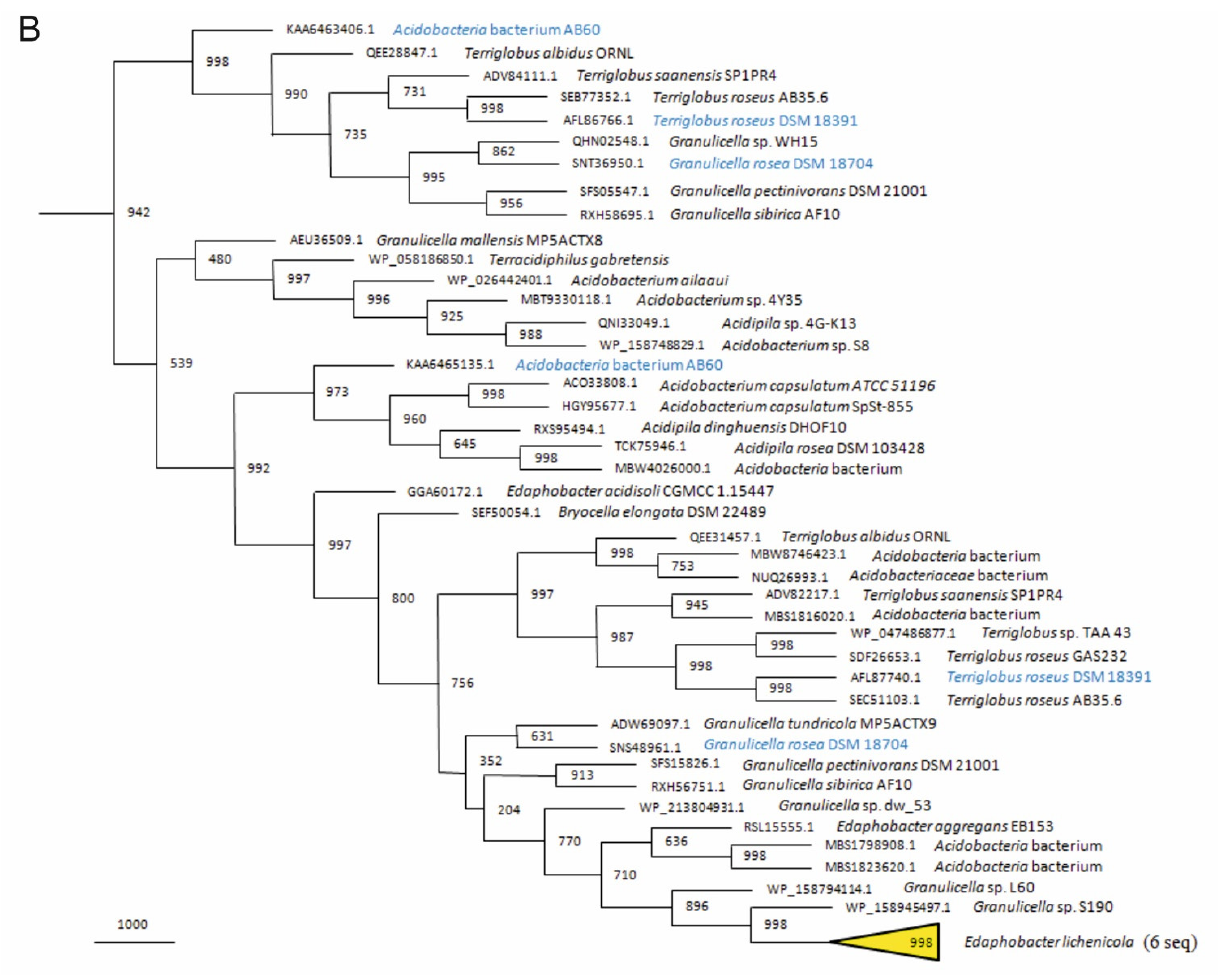
Figure 7. The maximum parsimony phylogenetic tree of the acidobacterial catalytic subunit BcsAB of cellulose synthase. Statistical significance of the tree was assessed by bootstrap analysis; the number of supporting pseudoreplicates (out of 1000) is indicated next to each branching site. ( A ) A simplified scheme of the phylogenetic tree with six undisclosed branch clusters (I–VI) of closely related proteins. The bootstrap support of each cluster is given within the corresponding triangle, and the number of proteins is indicated next to the triangle. Cluster I contains nine proteins encoded by metagenomes (GenPept: MBE7544888.1, MBI1352977.1, MBI4909624.1, MBL0156305.1, MBL8212404.1, MBN8729825.1, MBV8549744.1, PYV80644.1, and PYX09599.1). Cluster VI contains six proteins encoded by different strains of Edaphobacter lichenicola (MBB5315980.1, MBB5331838.1, MBB5338266.1, MBB5346008.1, NYF52494.1, and NYF89476.1). Structure of the four clusters (II–V) is shown in ( B ). Protein ACPOL_3662 (AXC12945.1) from Acidisarcina polymorpha SBC82 T is shown in red. Proteobacterial proteins with experimentally characterized enzymatic activity are indicated by red asterisks. Red rectangle corresponds to the tree fragment shown in ( B ). ( B ) Fragment of the phylogenetic tree in more detail. Species names are indicated for all proteins. Organisms represented in Figure 6 are shown in blue (for both